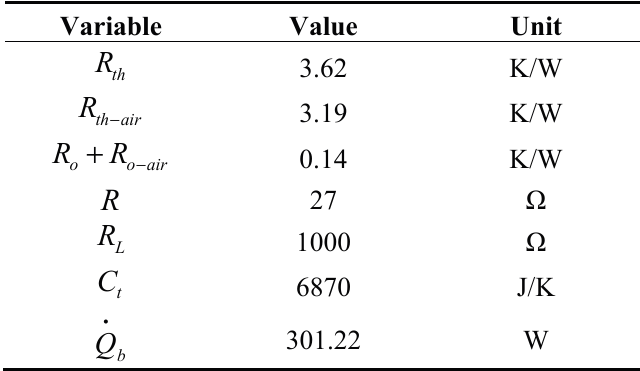
Table 2. Variables used in the model of a thermoelectric generator with a bearing.